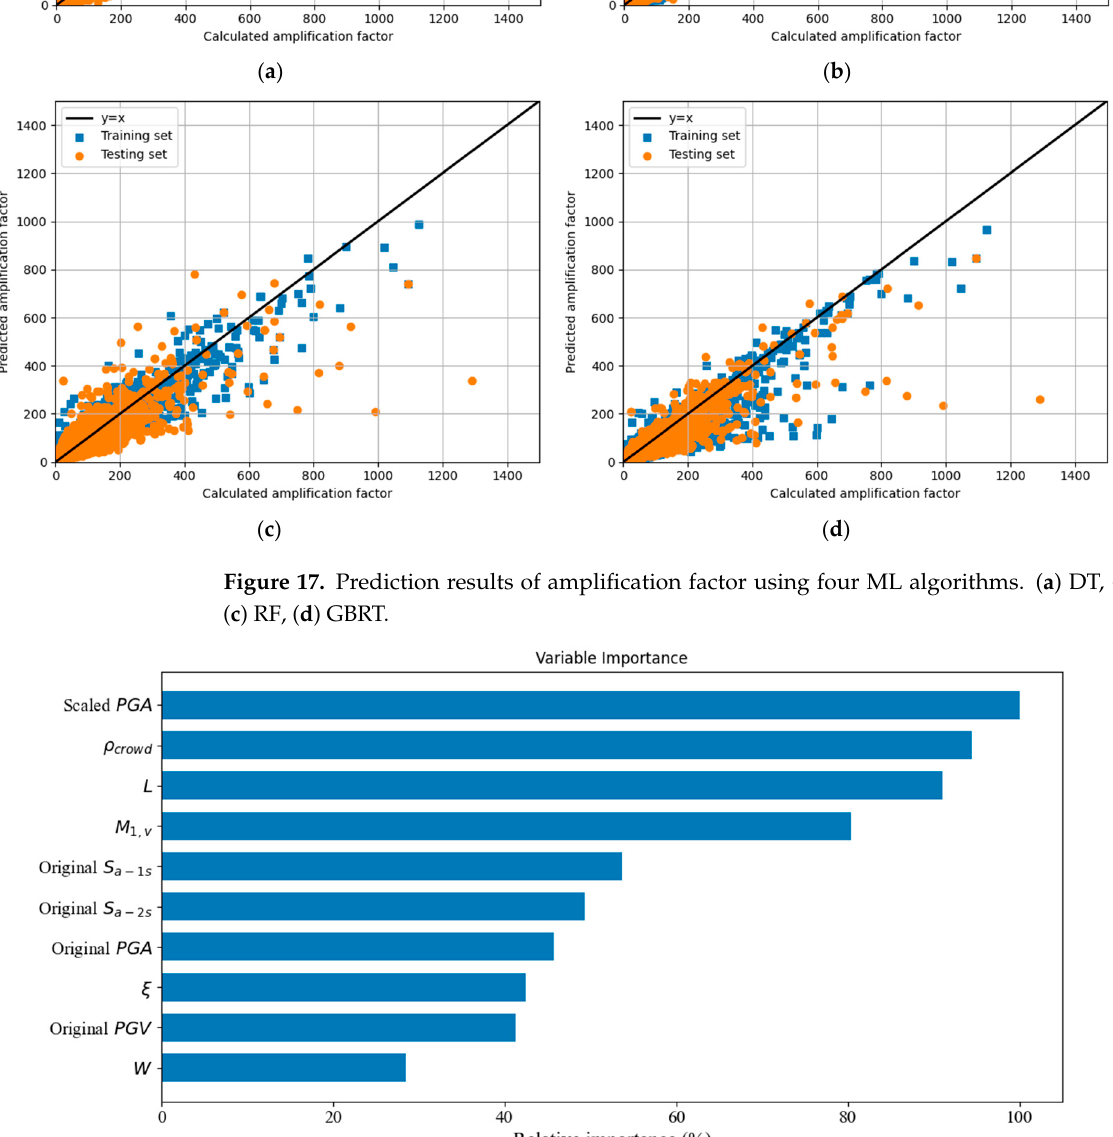
Figure 17. Prediction results of amplification factor using four ML algorithms. ( a ) DT, ( b ) ANN, ( c ) RF, ( d ) GBRT.